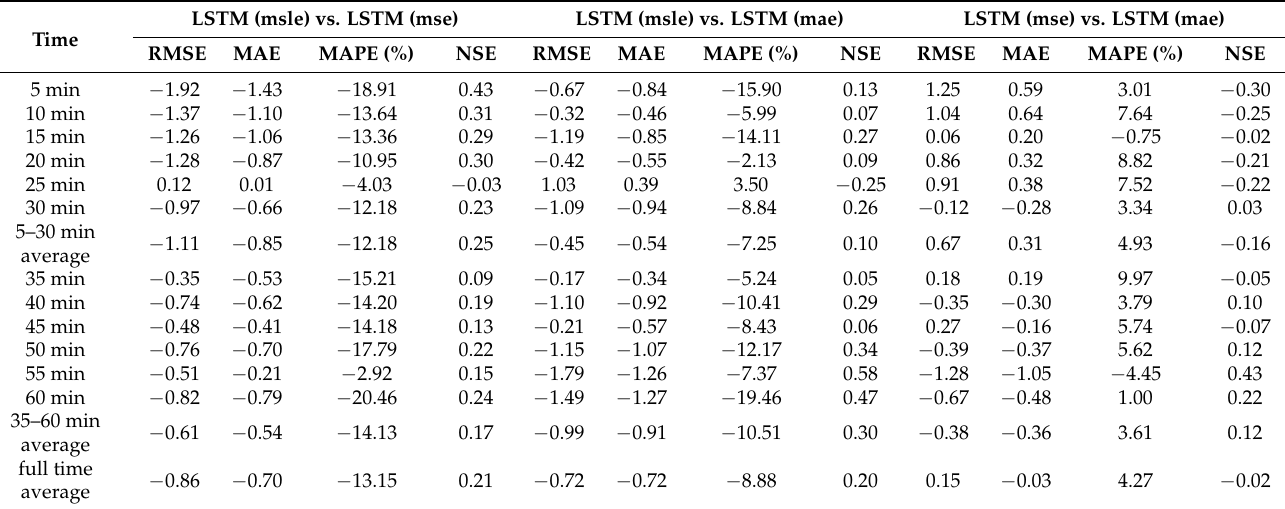
Table 1. Model accuracy comparison.